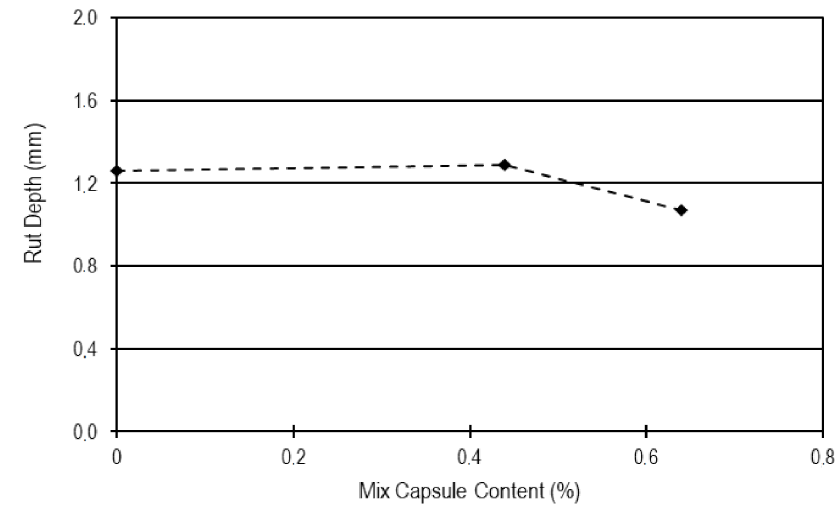
Figure 5. Wheel tracking results—resistance to rut deformation.